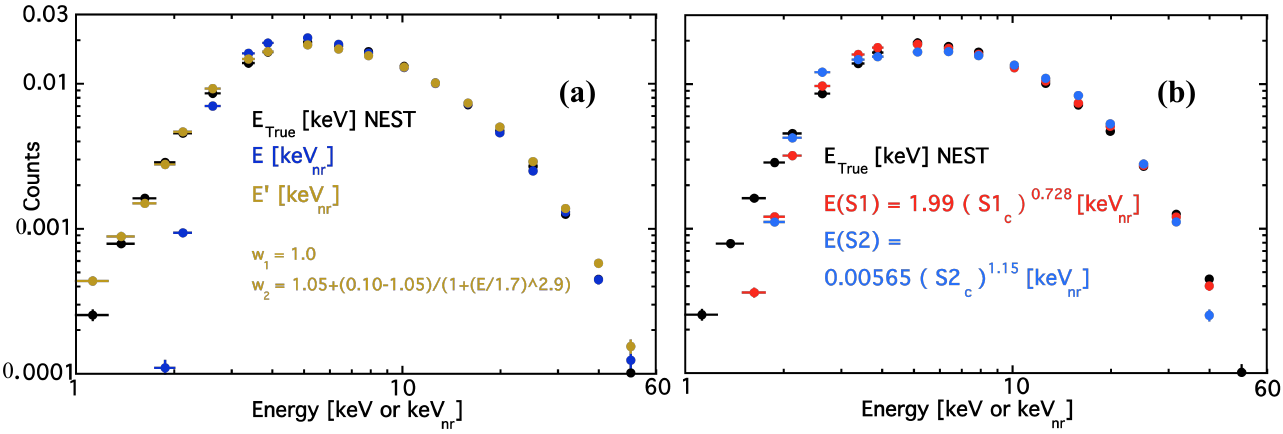
Figure 6. ( a ) Combined (blue) and optimal (yellow) scales for a 50 GeV standard weakly interacting massive particle (WIMP) spectrum, the MC truth for which is black. Above 2 keV, bins are omitted in log fashion for clarity. LUX detector parameters (i.e., Run03, first WIMP search) used as earlier for similar ER plot, again for illustrative purposes ( ∼ 180 V/cm). Yellow corrects for sub-keV efficiency underestimation, and an overestimation at several keV, comparing yellow to black and blue to black (these effects can change from detector to detector, with signal shape). While a distinct functional form vis-à-vis ER, w 2 is again S-shaped. Better results may be possible with lower w 1 , kept fixed at 1.0 again here for simplicity. In actual data, with ER and NR mixed, backgrounds with potential signals, it is impossible to know a priori if applying keV nr or ee is more appropriate by event. ( b ) True spectrum is repeated, but now compared with S1/S2 in red/cyan. Power laws in the legend are crude, detector-specific approximations, but can be converted using S 1 c = g 1 N ph , S 2 c = g 2 N e − ( g 1 = 0.117, g 2 = 12.1). For why both powers are ∼ 1, please see Equation